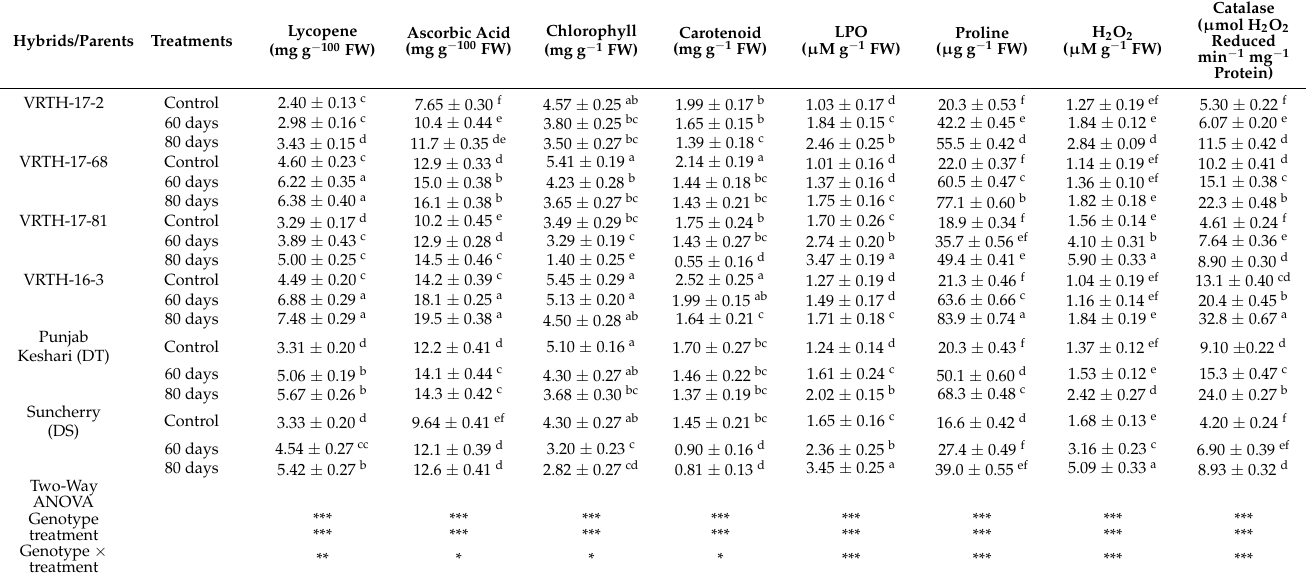
Table 4. Changes in nutritional and antioxidant capacity in tomato hybrids/parents under drought stress.